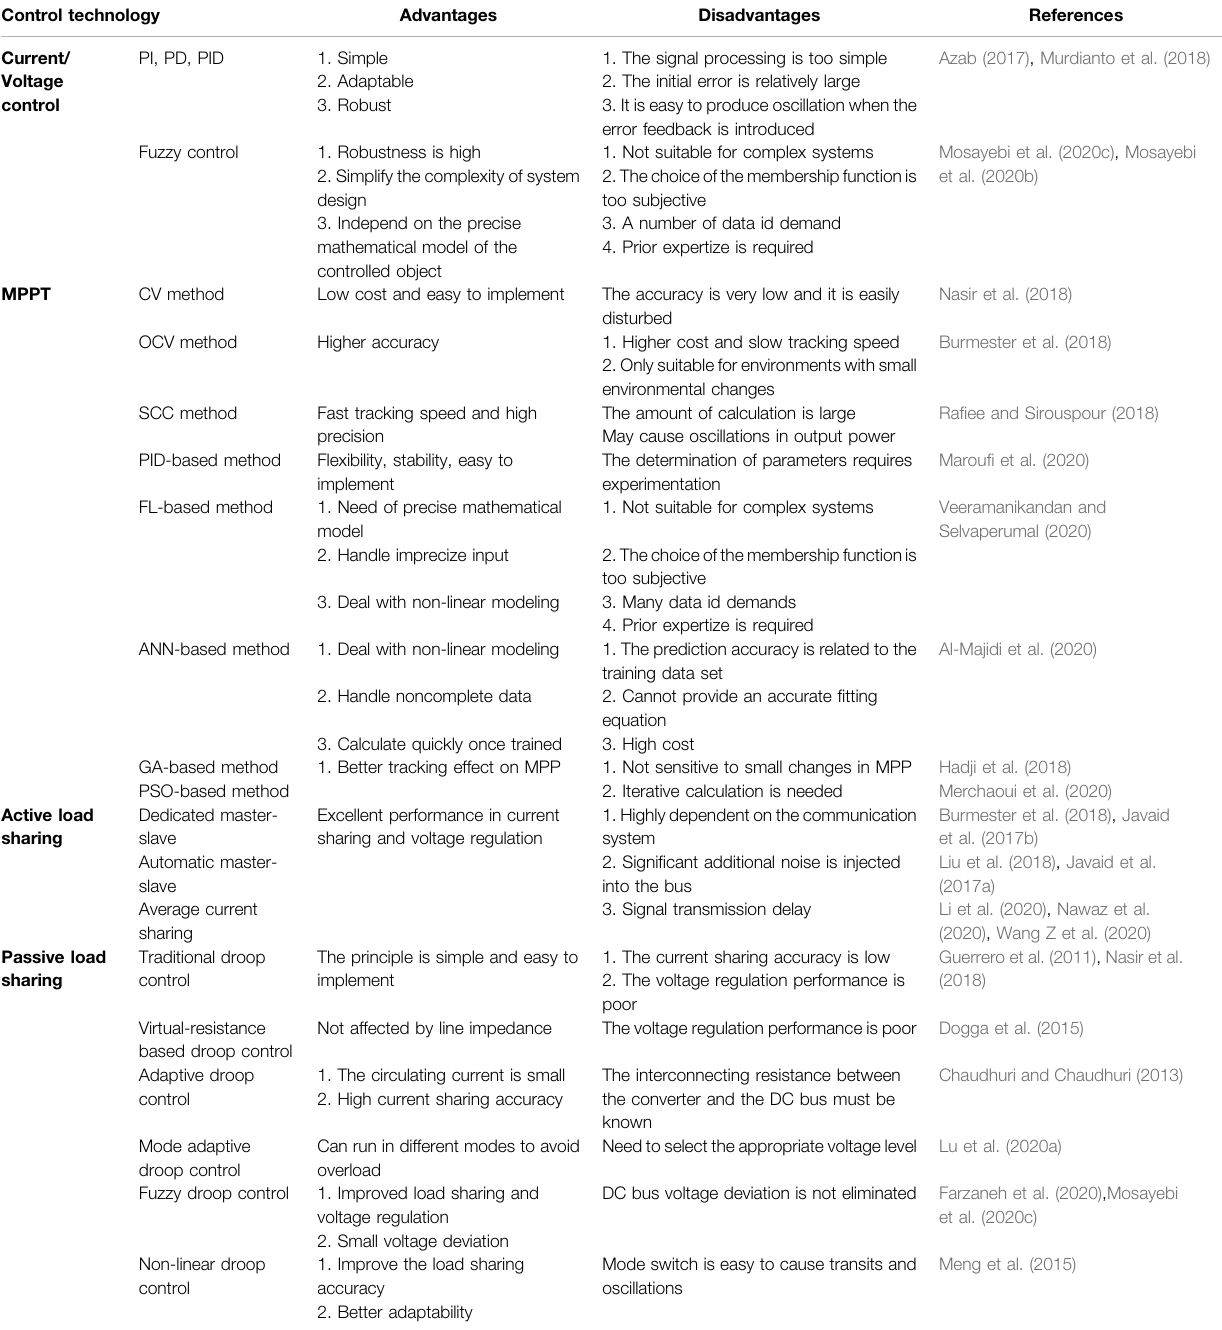
TABLE 2 | Comparison of local control